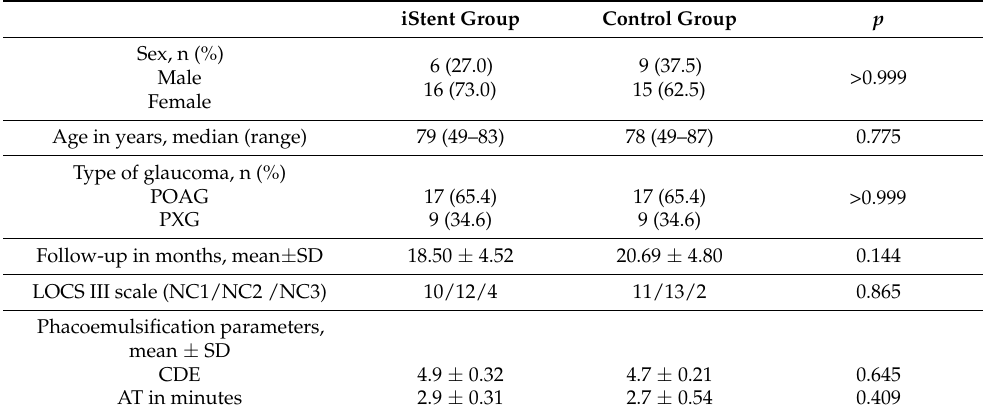
Table 1. Clinical characteristics of studied group of patients.